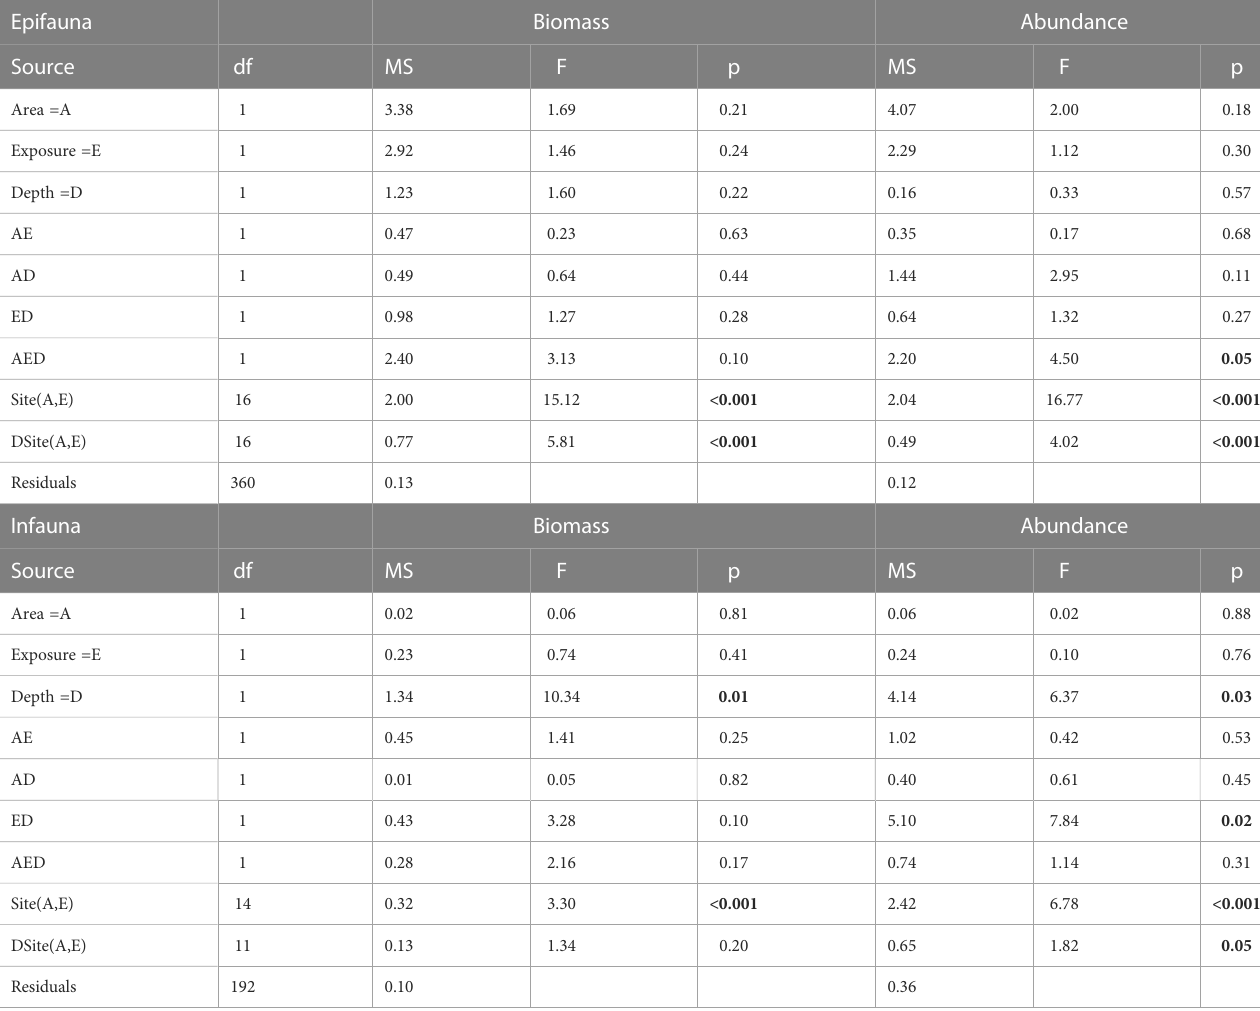
Bold numbers represent signi fi cant